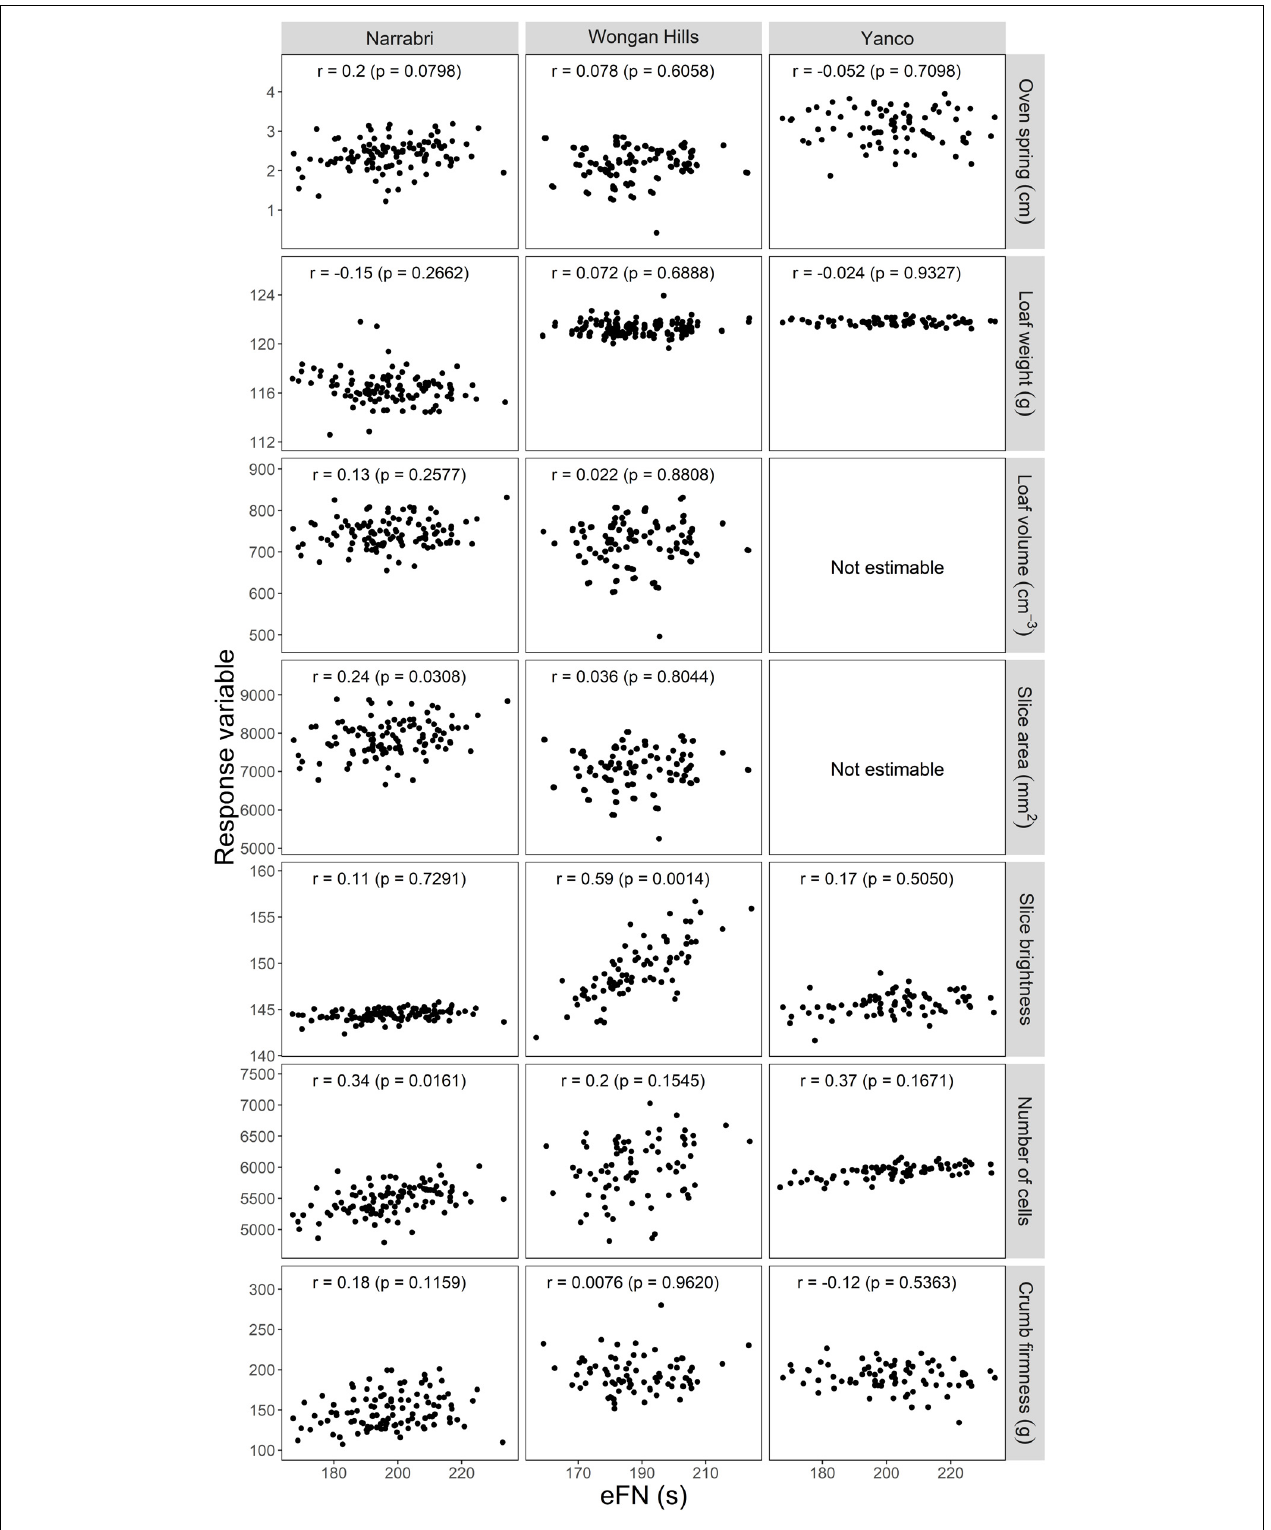
FIGURE 3 | Scatterplots of milled-sample level BLUPs and associated correlations ( r ) between equivalent Falling Number (eFN) and bread quality traits for the three sites, Yanco, Narrabri, and Wongan Hills, with associated REML likelihood ratio test p -values. Associated numbers of plotted observations are n = 77 (Yanco), n = 108 (Narrabri), and n = 78 (Wongan Hills). BLUPs for loaf volume and slice area at Yanco could not be estimated (see Section “Results”).